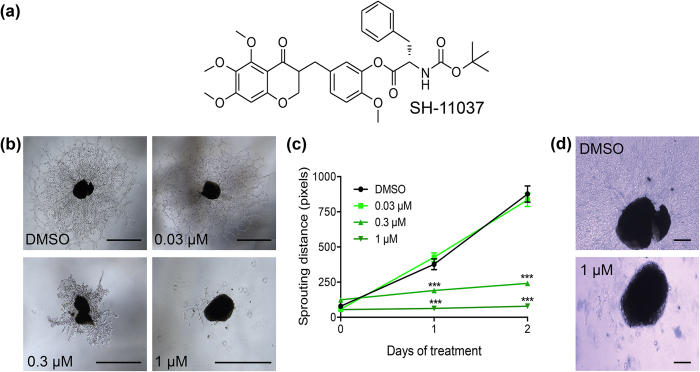
SH-11037 inhibits choroidal sprouting in a concentration-dependent manner without affecting cell viability.(a) Structure of SH-11037. (b) Representative images of choroidal sprouts formed 48 hours after treatment with indicated SH-11037 concentrations or DMSO control, scale bars = 1000 μm. (c) Quantification of sprouting distance from the edge of the choroid tissue piece to the end of the sprouts averaged from four perpendicular directions using ImageJ software. ***P < 0.001, repeated measures two-way ANOVA, Dunnett’s post hoc test, Mean ± s.e.m. n = 4 from two independent experiments. (d) Representative images of trypan blue stained choroidal sprouts 48 hours after treatment with DMSO and 1 μM SH-11037 to assess cell viability, scale bars  =  1000 μm.